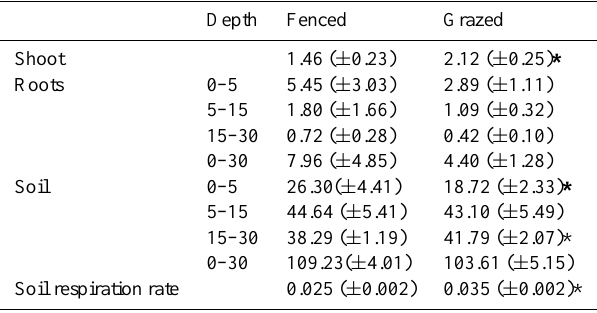
Table 2. Mean ( ± SD) C stocks (MgCha − 1 ) aboveground and belowground C pools, and mean ( ± SD) soil respiration rate (MgCha − 1 d − 1 ) during the chase period in the fenced and grazed